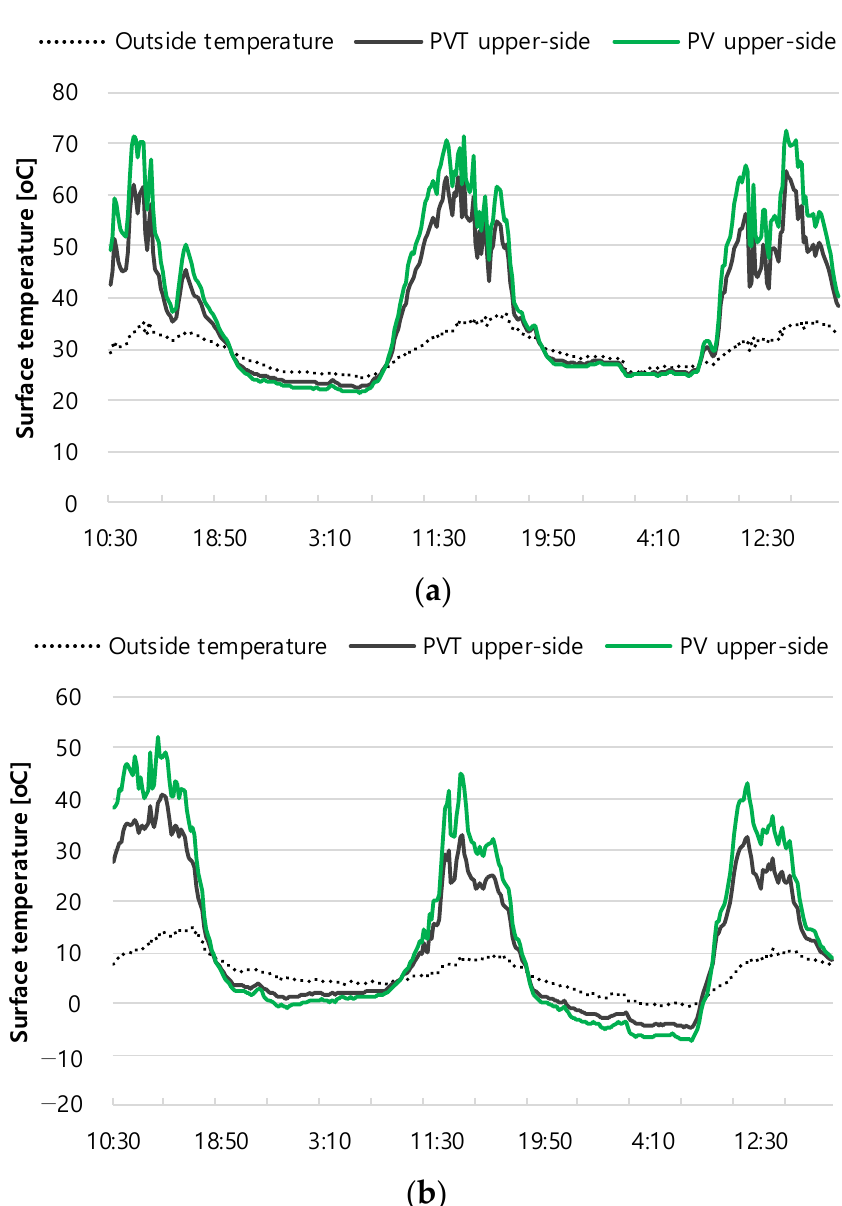
Figure 3. Upper surface temperature of the panels: ( a ) summer; ( b ) winter. The temperature of the air passing through the PVT panel increases through heat exchange with the panel. The temperature of the passing air of the panel heated by solar radiation showed a maximum temperature increase of 4.8 ◦ C and an average of 3.3 ◦ C in summer and a maximum temperature increase of 4.9 ◦ C and an average of 1.8 ◦ C in winter (Figure 5). It is judged that such an increase in atmospheric temperature has a high correlation with insolation. As the amount of insolation increases, the exit temperature also rises, thus it is judged that the optimum efficiency will be exhibited when the maximum amount of insolation is obtained by adjusting the angle of sunlight entering the panel (Figure